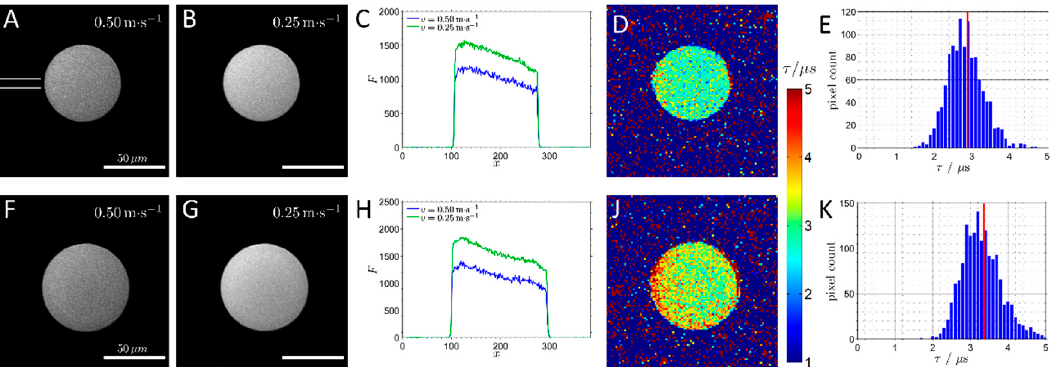
Figure 6. Luminescence lifetime imaging of agarose beads with immobilized Ru(dpp) 3 immersed in air-saturated buffer ( A – E ) and in buffer with enzymatically depleted oxygen ( F – K ). The luminescence intensity of the beads is lower at higher scan speed ( A , B , F , G ). ( C , H ) The intensity profiles across the central part of the beads, as marked by two white lines in ( A) . ( D , J ) The luminescence lifetime images. ( E , K ) Pixel lifetime distributions of the beads shown in ( D ) and ( J ) with the mean values marked by red lines. Reproduced with permission from reference [64]. Copyright (2016) American Chemical